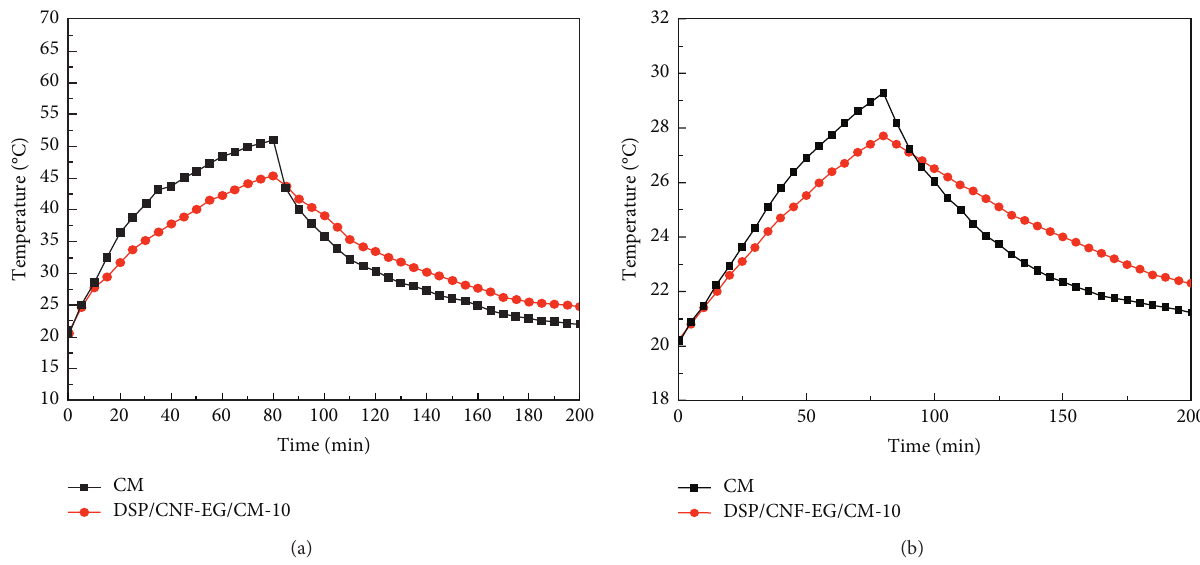
Figure 7: Thermal performance comparison between CM and DSP/CNF-EG/CM-10: (a) the temperature-time curves at the lower central surface of CM and DSP/CNF-EG/CM-10 specimens and (b) the temperature-time curves in the center position in the test